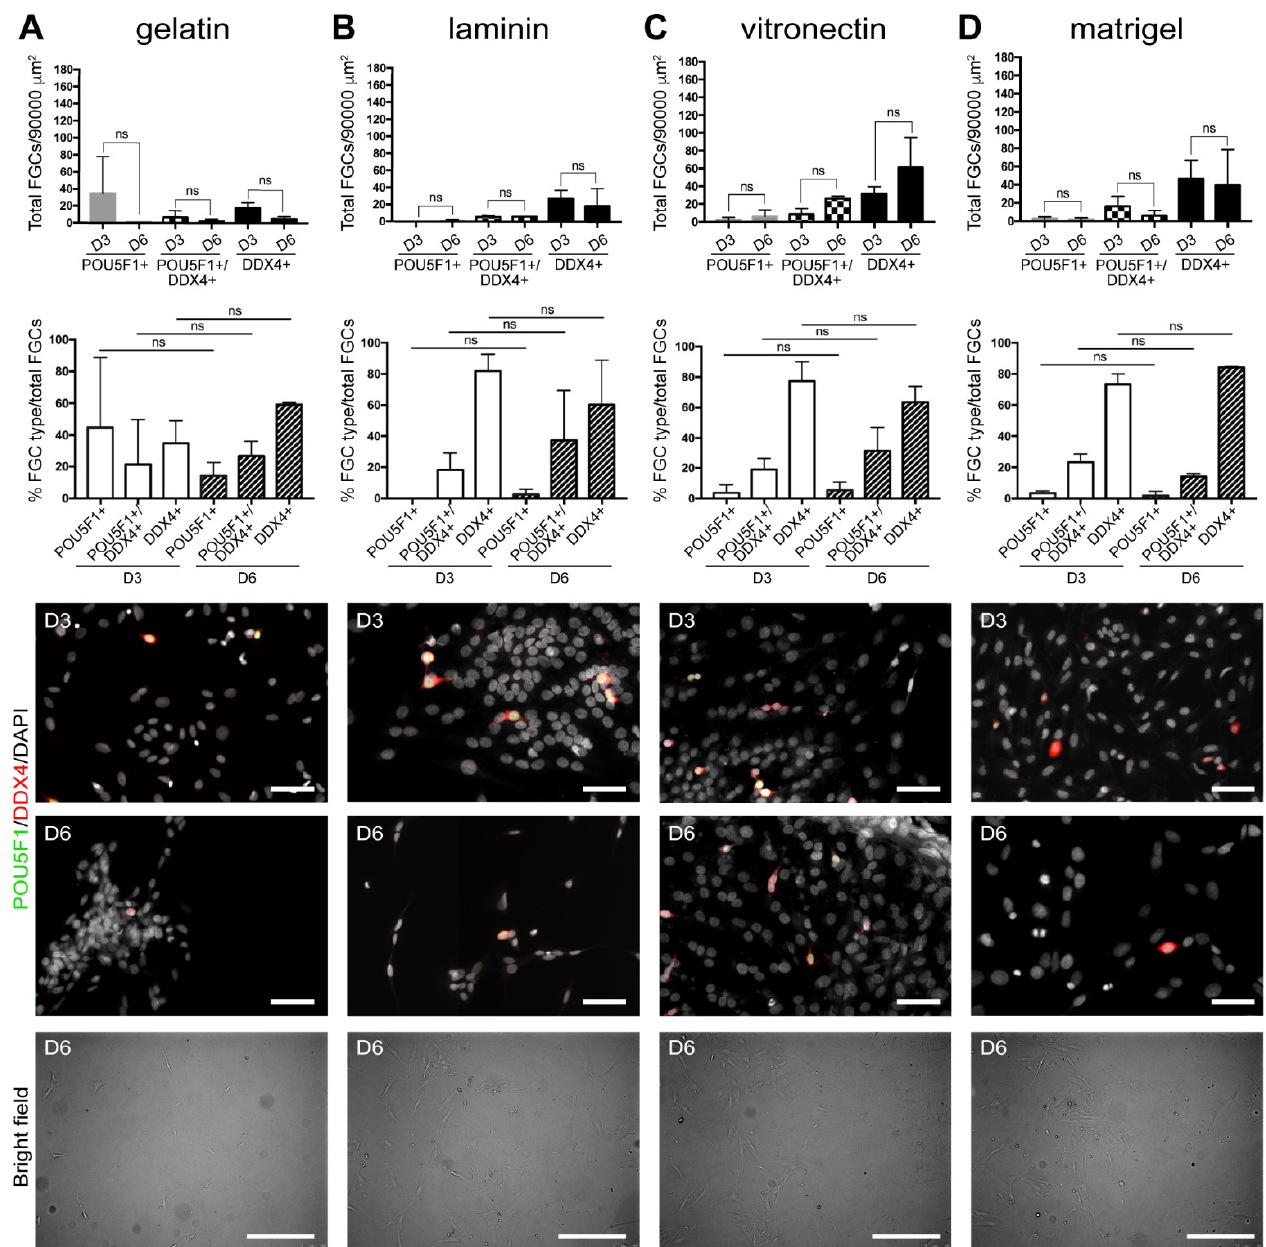
Figure 3. Quantification of hFGCs in the adapted Zhou-medium and different substrates. Quantification of the total number of hFGCs ( n = 2 different donors) per 90,000 µ m 2 and the percentage of different hFGC types (POU5F1+, POU5F1+DDX4+ and DDX4+ cells) grown for 3 and 6 days in gelatin-coated substrate ( A ), laminin-coated substrate ( B ), vitronectin-coated substrate ( C ) and matrigel-coated substrate ( D ). All data are represented as mean ± SEM. Statistical analysis was performed by using the t -test (ns, not significant). For immunofluorescence, nuclei were counterstained with DAPI (white). Scale bars: 50 μ m in immunofluorescence images and 300 μ m in bright field images.